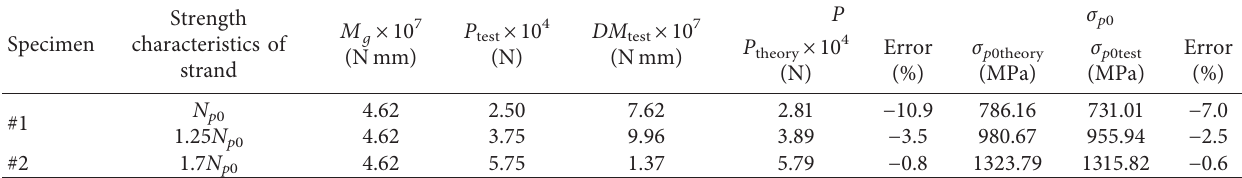
Table 2: Error analysis of the calculated results with different strength characteristics. Strength Specimen characteristics